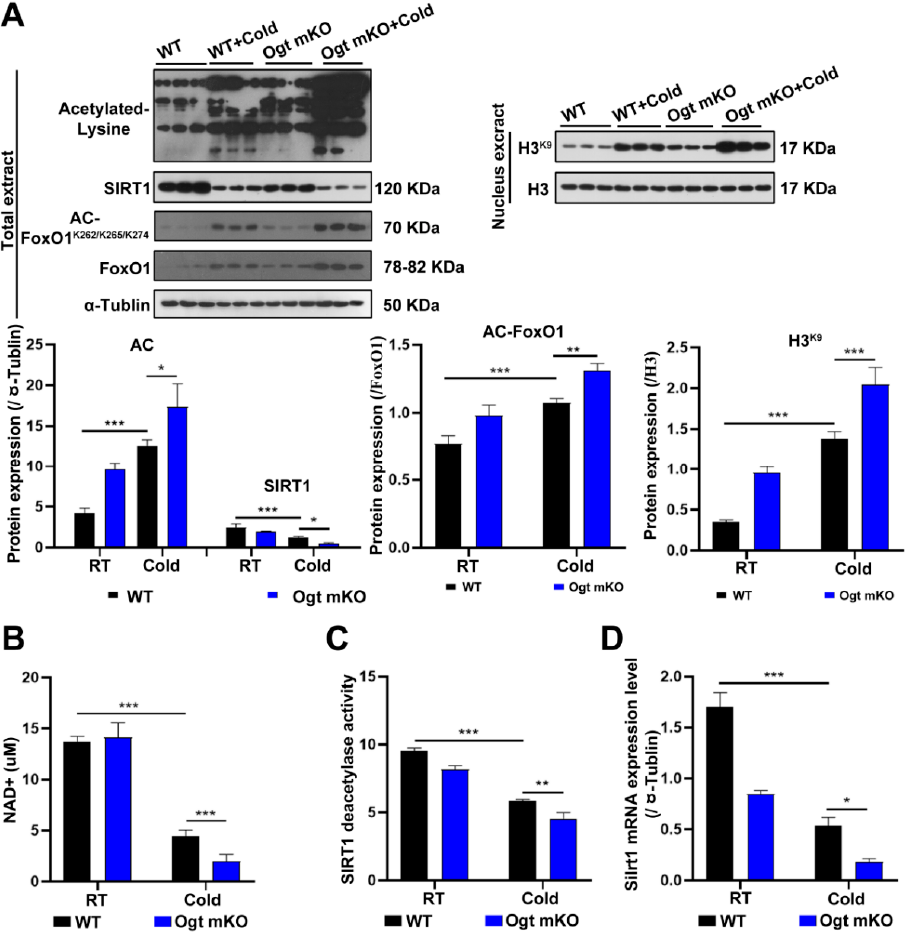
Figure 3. CS enhances protein acetylation via downregulation of SIRT1. ( A ) After CS treatment, fresh SM tissues of four groups (WT group, WT + cold group, Ogt mKO group, Ogt mKO + cold group) were collected and prepared for Western blotting analysis using antibodies against acetyl-Lys, SIRT1, acetyl-FoxO1, FoxO1, and tubulin. Expression of H3 K9 and H3 in the nuclear extract of SM cells. ( B – D ) Fresh SM tissue was collected to detect ( B ) NAD + content, ( C ) SIRT1 activity, and ( D ) Sirt 1 mRNA expression. All results contain 3 replicates per group (n = 3/group). Data are presented as means ± sd and were analyzed by two-way ANOVA. * p < 0.05, ** p < 0.01, *** p < 0.001.